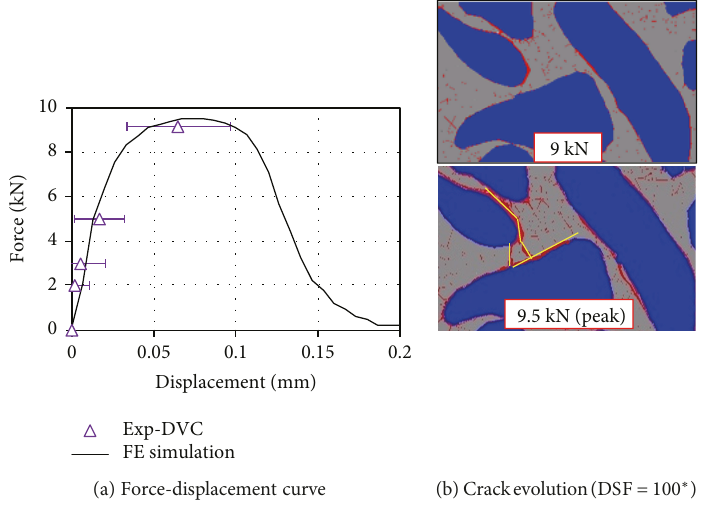
Figure 12: Force-displacement curve and crack evolution validation. ∗ DSF is displacement scale